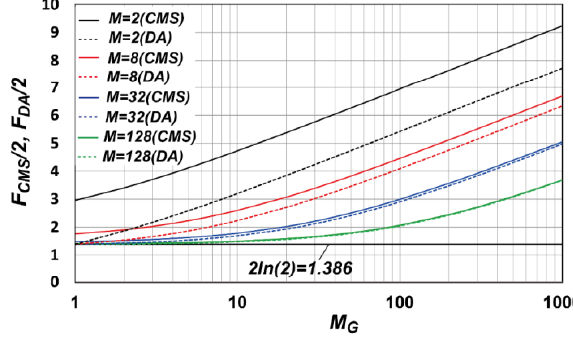
Figure 8. Noise reduction factor of the CMS, F CMS , and differential averager, F DA , as a function of M G and M .